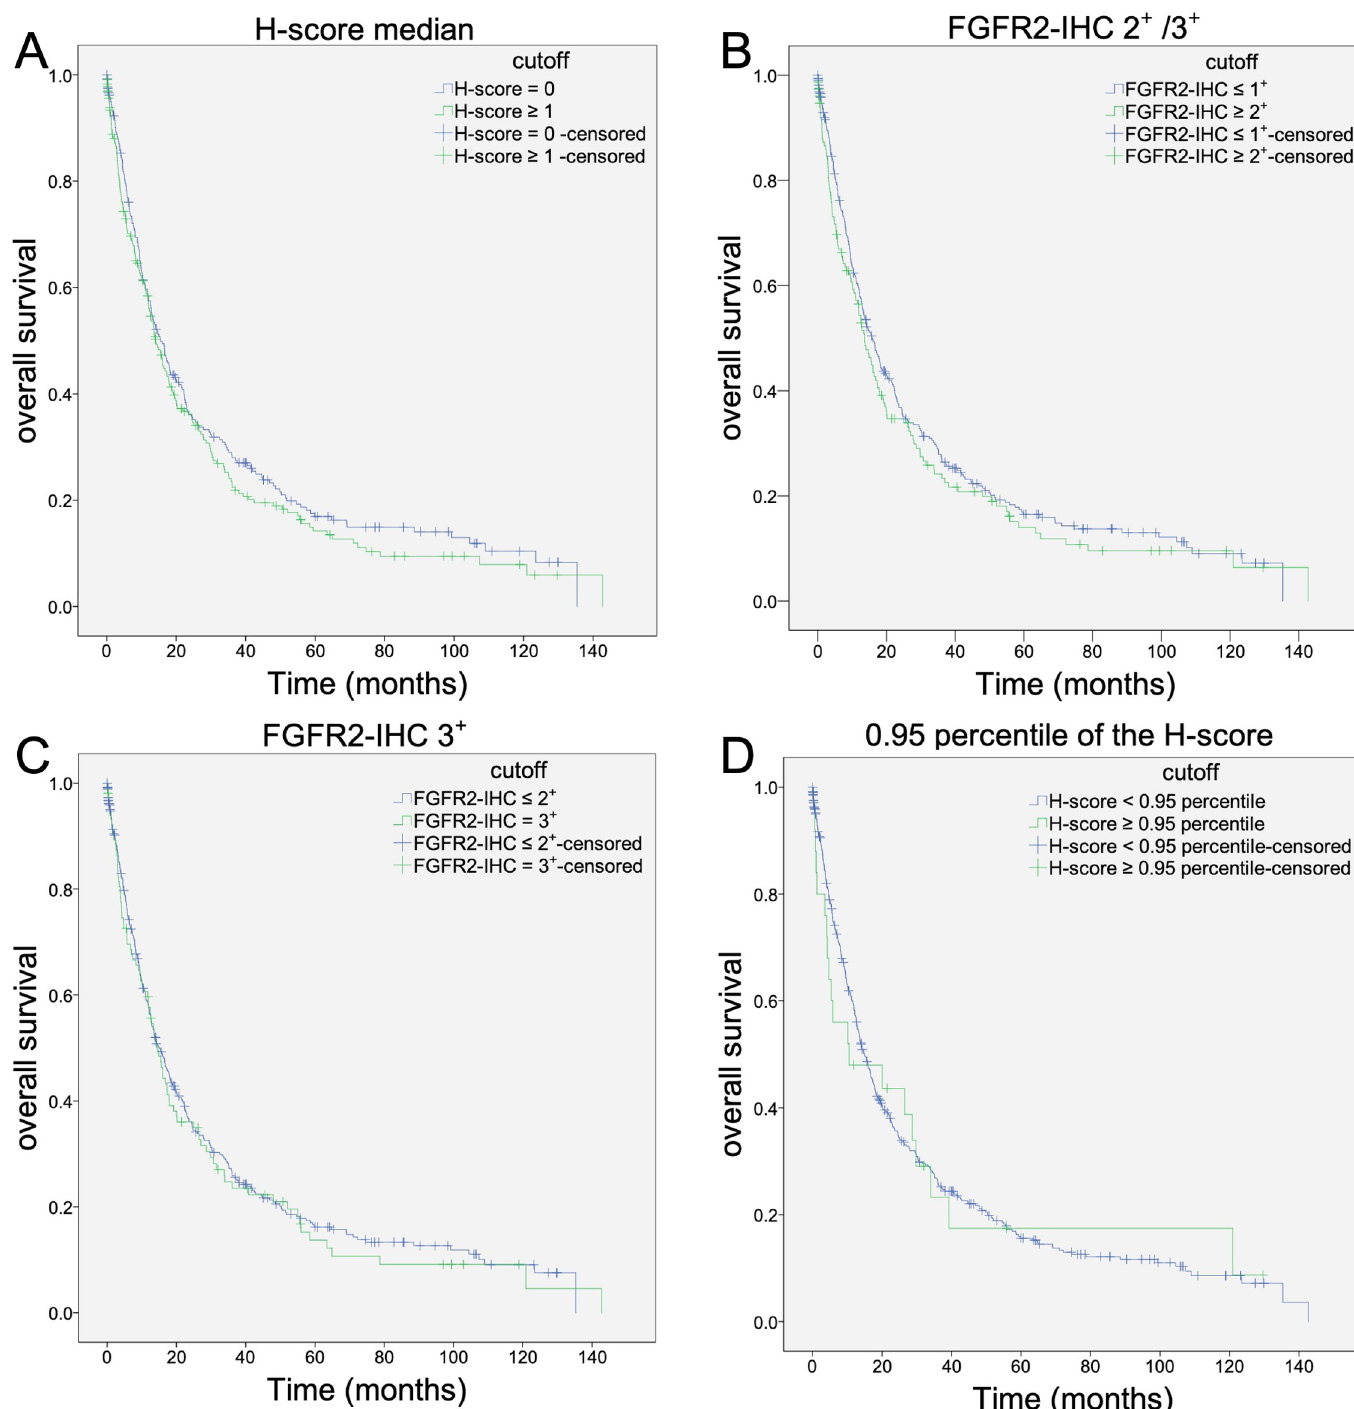
Fig 3. Analysis of patient overall survival using different definitions of FGFR2 positivity in the immunohistochemical examinations. Analysis of survival data was first performed for the entire cohort. Using different thresholds to define increased FGFR2 protein expression, there was no difference in overall or tumor-specific patient survival. Initially, the median Hscore was used as a cutoff (A). The presence of FGFR2-IHC 2+ or 3+ (B) and the exclusive presence of FGFR2-IHC 3+ (C) were also examined. Finally, the 0.95 percentile of the Hscore was used as a cutoff (D).